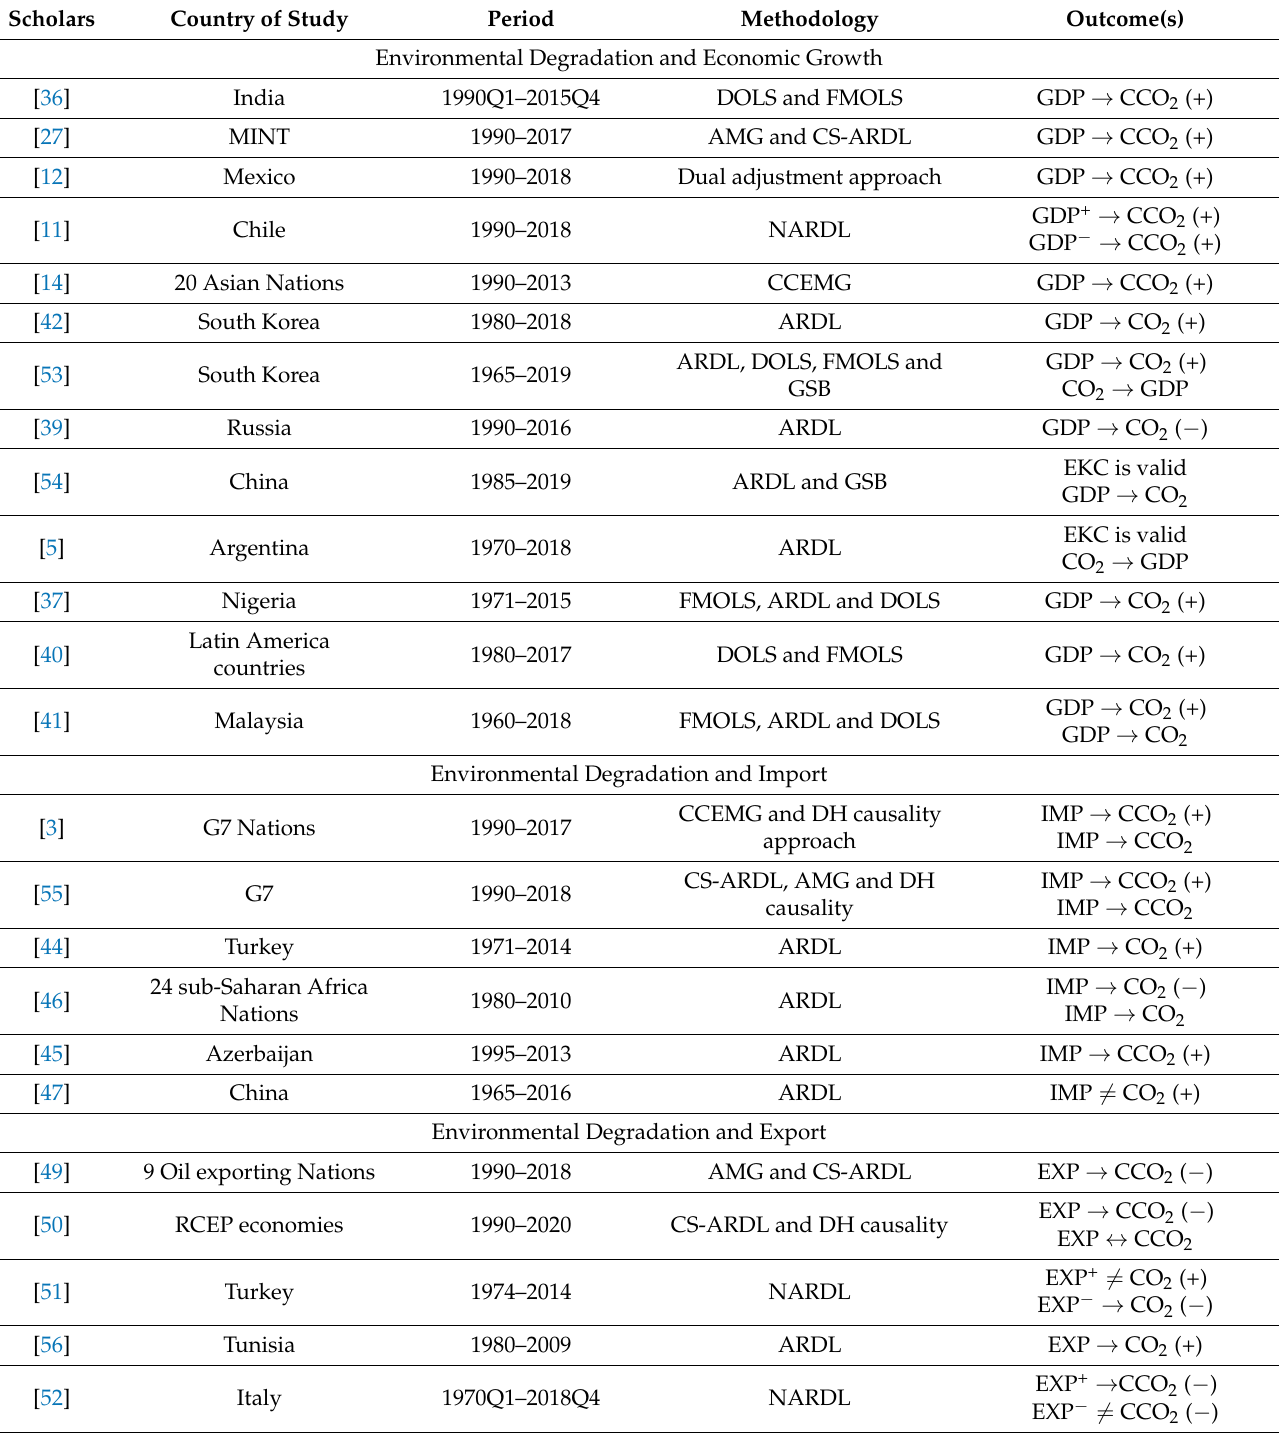
Table 1. Summary of Related